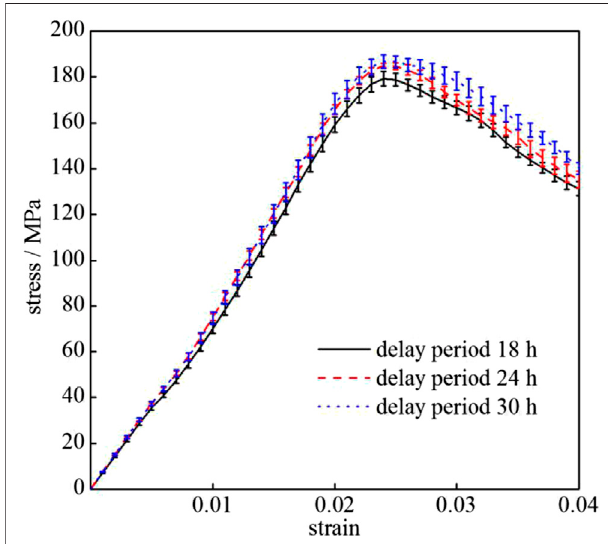
Figure 4 | Stress-strain curves of RPC under different delay period.